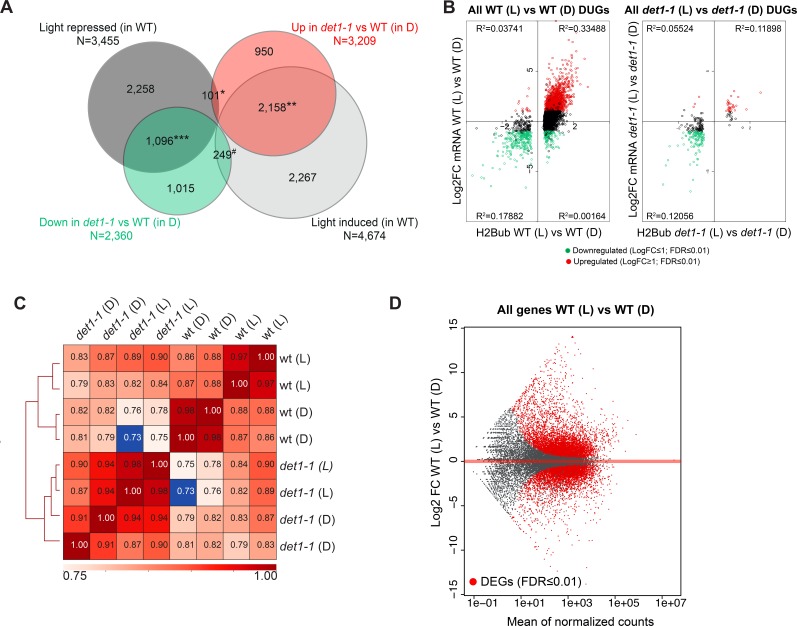
Light and DET1 massively influence H2Bub enrichment over protein-coding genes.(A) The det1-1 mutation has a broad effect on gene expression and largely mimics the effect of light on the transcriptome of dark-grown seedlings. The majority of changes in gene expression induced by light exposure of the WT no longer occurred in det1-1 plants, often because of their constitutive expression in darkness in det1-1 seedlings. Venn diagrams represent 2-fold misregulated genes in the indicated samples (FDR < 0.01). *Representation factor: 0.3 (p-Val < 9.171e-81); **Representation factor: 4.1 (p-Val < 0.0e + 00); ***Representation factor: 3.8 (p-Val < 0.0e + 00); #Representation factor: 0.6 (p-Val < 2.254e-17). (B) Small variations in H2Bub levels correlating with gene expression can still be detected in det1-1 plants. The scatter-plot represents H2Bub and transcript level variations of DUGs in light (L) compared to dark (D) conditions in WT and det1-1 plants. The x-axis shows Log2 fold-changes (FC) of H2Bub levels as determined by DESeq2 analysis upon scaling according to ChIP-Rx normalization factors (FDR < 0.01). The y-axis shows Log2 FC of transcript levels as determined by DESeq2. Red and green colored dots represent the up- and down-regulated genes, respectively, between light and dark conditions (Log2 FC > 1, FDR < 0.01). Only expressed genes bearing a significant H2Bub domain according to MACS2 peak detection are shown. (C) Correlation analysis of read counts in all replicates confirmed a dual effect of both light and det1-1 mutation on global H2Bub dynamics. The heatmap represents Spearman correlations in read counts over all positions of the genome for each ChIP-seq replicate that was computed using Multibigwig Summary and plotCorrelation from deepTools. The analysis shows diverging distributions between WT and det1-1 genotypes, as well as a sub-partitioning of WT samples according to the light condition. (D) Differential analysis of transcript levels between dark- and light-grown wild-type seedlings showed similar amplitude of up- and downregulation. MA-plot representation of expressed genes in the two conditions that allows visualizing differentially (DEGs; FDR < 0.01; red dots).